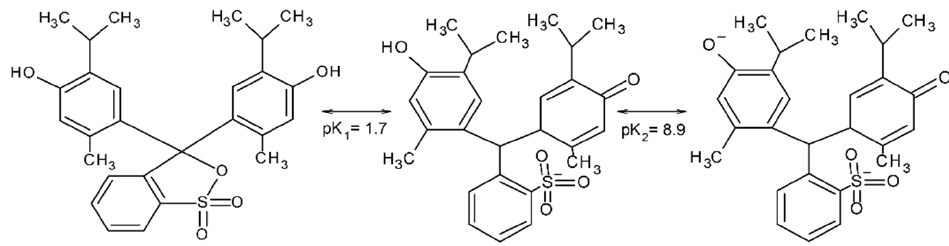
Figure 1. Structures of thymol blue at different